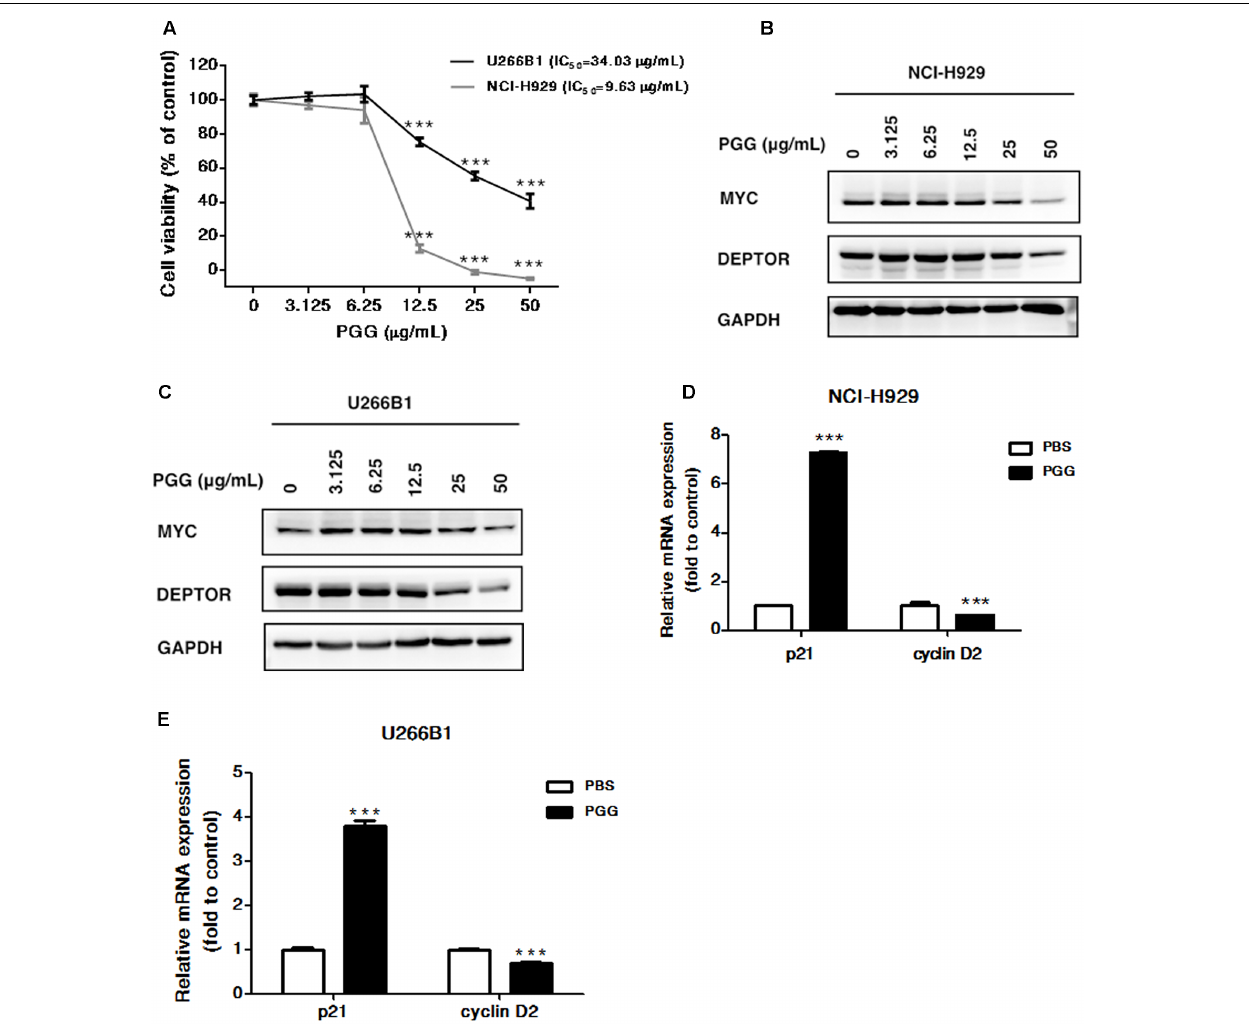
FIGURE 3 | Effect of PGG treatment on NCI-H929 and U266B1 cells (A) The viability of NCI-H929 and U266B1 cells were analyzed after PGG treatment for 72 h and determined by alamarBlue R (cid:13) assay as described in Section “Materials and Methods.” IC 50 value of PGG is shown in the figure. Results are means ± SD ( n = 3). MYC and DEPTOR protein expression in NCI-H929 (B) and U266B1 (C) cells treated with indicated concentrations of PGG for 24 h determined by immunoblot assay. GAPDH expression was used as a loading control. The upregulation of p21 and inhibition of cyclin D2 mRNA expression in NCI-H929 (D) and U266B1 (E) cells treated with PGG for 24 h determined by qRT-PCR. ∗∗∗ P < 0.001 (Student’s t